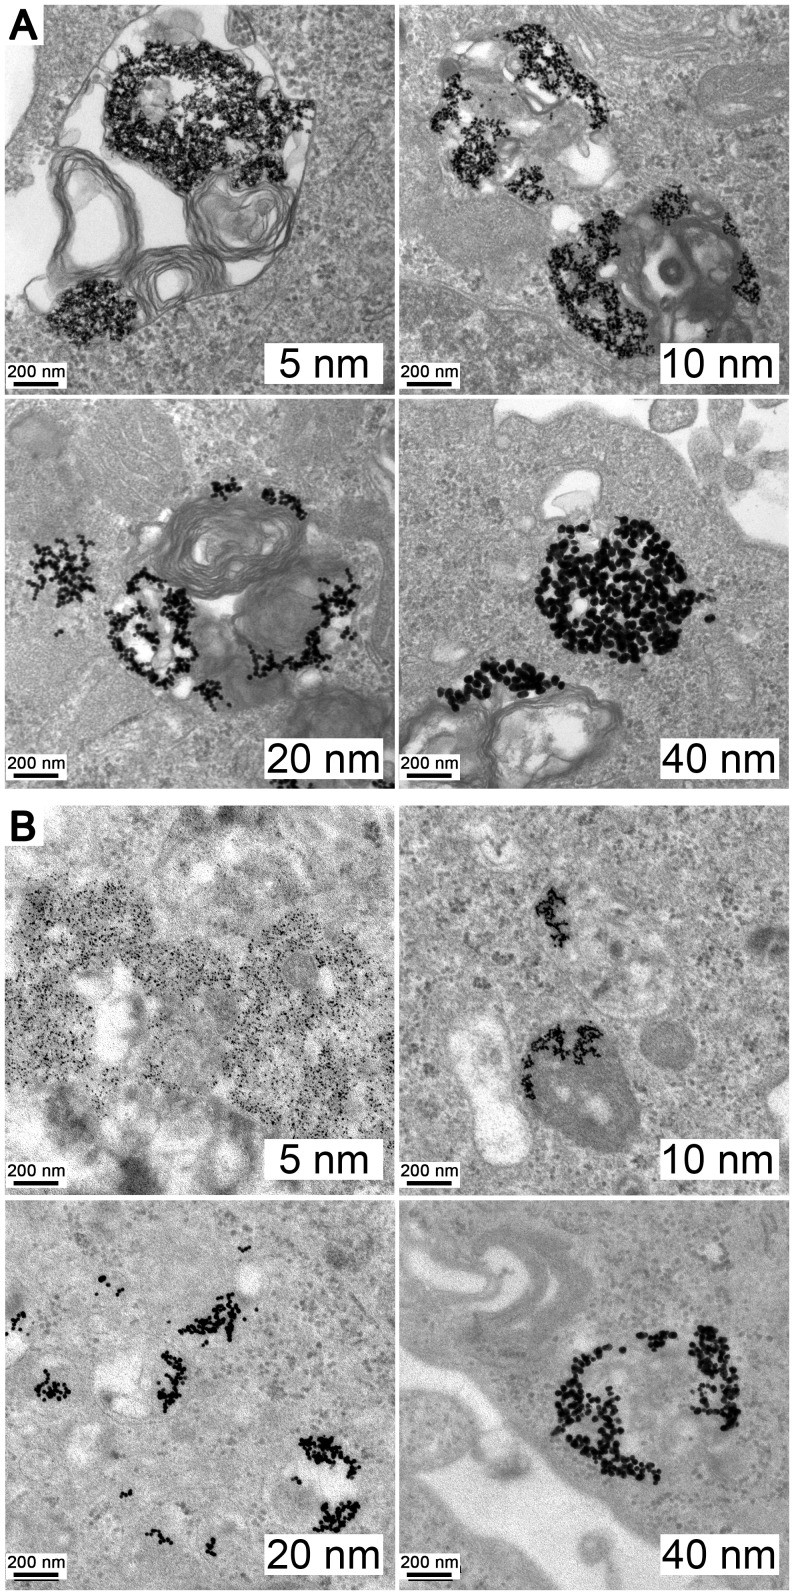
Transmission electron microscopy (TEM) images of Au-NPs trapped inside the cells.TEM images at 200-nm magnification showing the internalization of 25 µg/mL Au-NPs with various sizes (5 nm, 10 nm, 20 nm, and 40 nm) into (A) A549 and (B) 95D cells after 48 h of treatment.